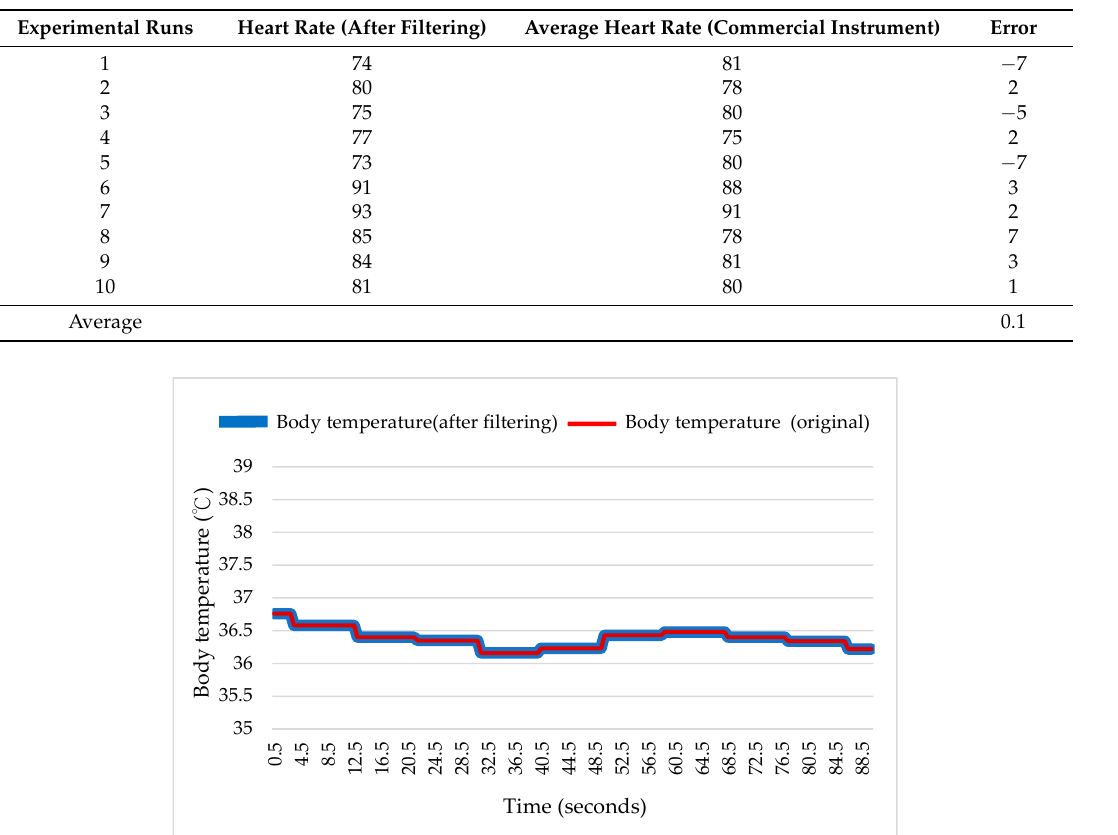
Table 6. Errors of the heart rates measured in this experiment with respect to data measured using a commercially available sphygmomanometer.